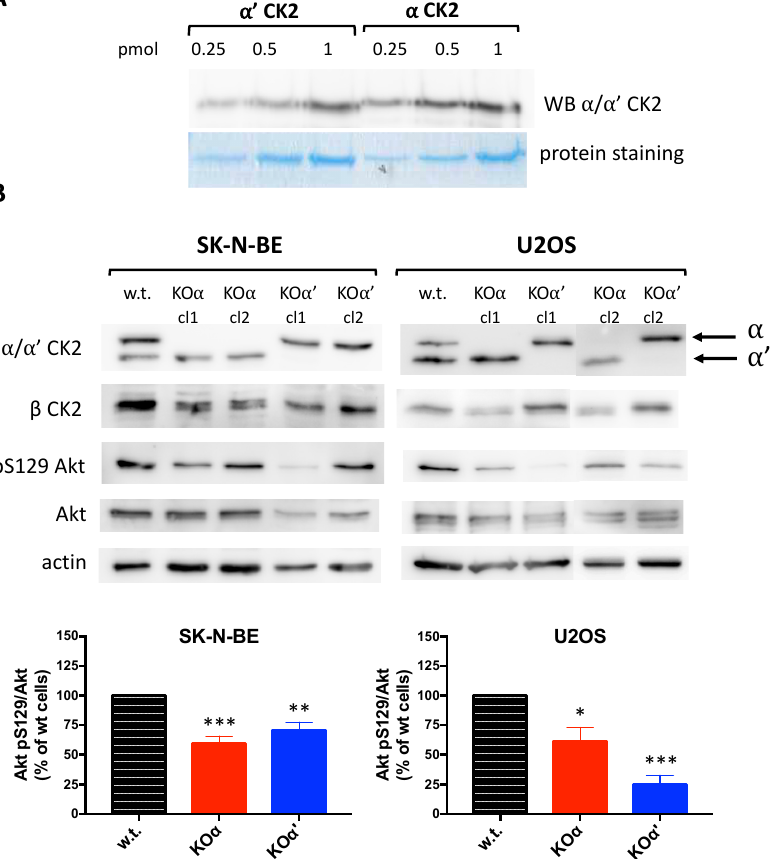
Figure 1. CK2 expression and activity in SK-N-BE and U2OS cells. ( A ) Titration of the antibody reactivity towards CK2 catalytic subunits. The indicated amounts of recombinant CK2 catalytic subunits (myc- α ’ or α ) were loaded on SDS-PAGE, and either blotted for the WB (western blot) analysis or stained by Colloidal Coomassie Blue; ( B ) CK2 expression and activity in w.t. and KO clones of the cells used for this study. 10 µ g proteins from cell lysates were analyzed by WB with the indicated antibodies. The last two right lanes belong to an independent experiment. As a reporter of CK2 endogenous activity, pS129 Akt signal has been quantified, normalized to total Akt signal, and reported in the bar graph as % of w.t. cells. At least three independent experiments were performed; representative western blots are shown, while quantification in the bar graphs reports the mean values ± SEM of all experiments and of the two clones of the same KO. Statistical significance refers to w.t. cells. (*) p < 0.05, (**) p < 0.01, (***) p <